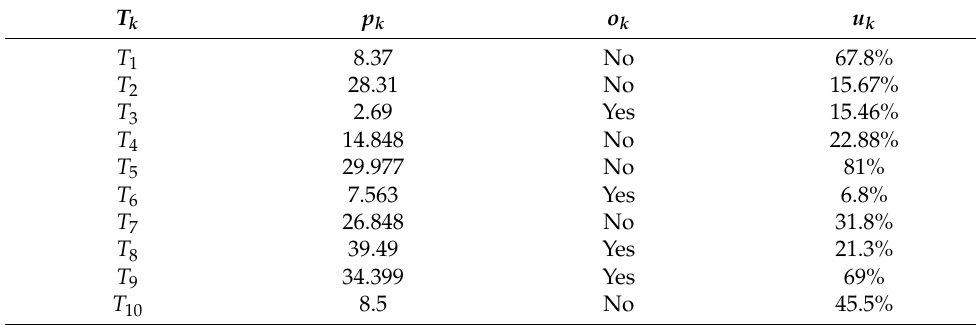
Table 3. Tasks T k information.